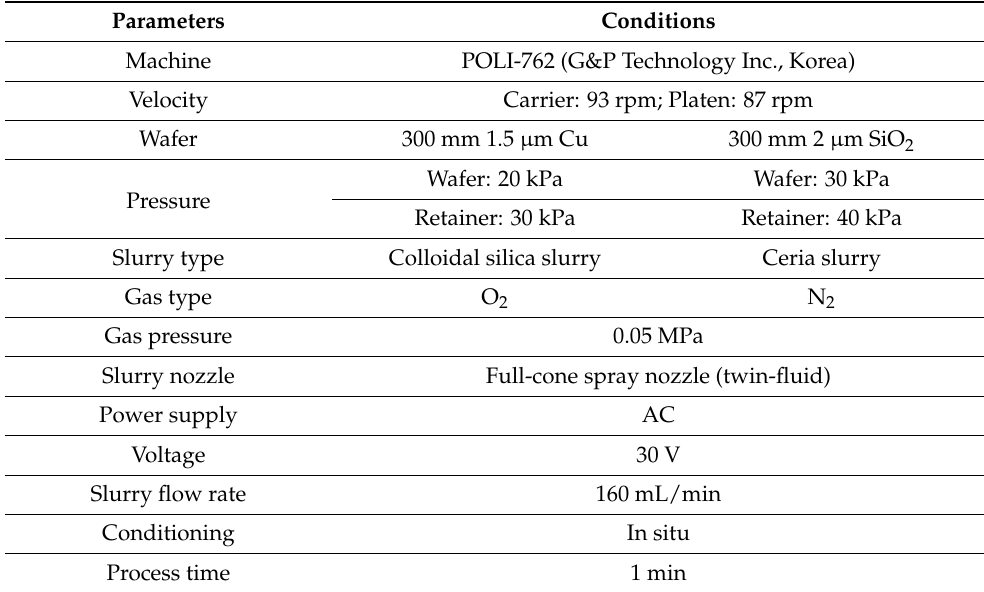
Table 1. Experimental conditions based on the wafer type for global planarization.